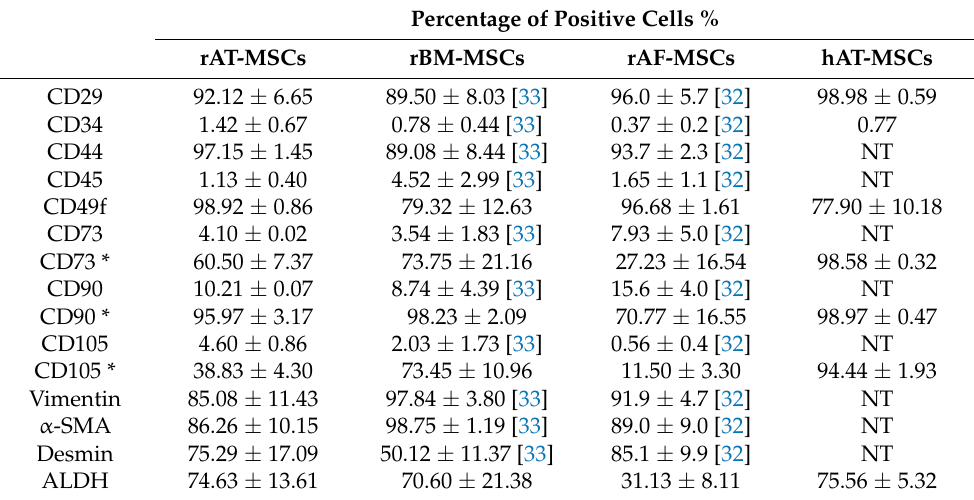
Figure 1. Morphological changes in rAT-MSCs during the culture. ( A ): Cells started to adhere to culture flasks 24 h after seeding; ( B ): the cells began to cluster into small colonies 72 h in culture; ( C ): the cells reached confluency approximately 50–60% on the 5th day; ( D ): cell culture consisted of a homogenous monolayer of fibroblast-like cells on the 7th day after isolation (scale bar = 100 µ m). Table 5. Detection of the expression of markers using flow